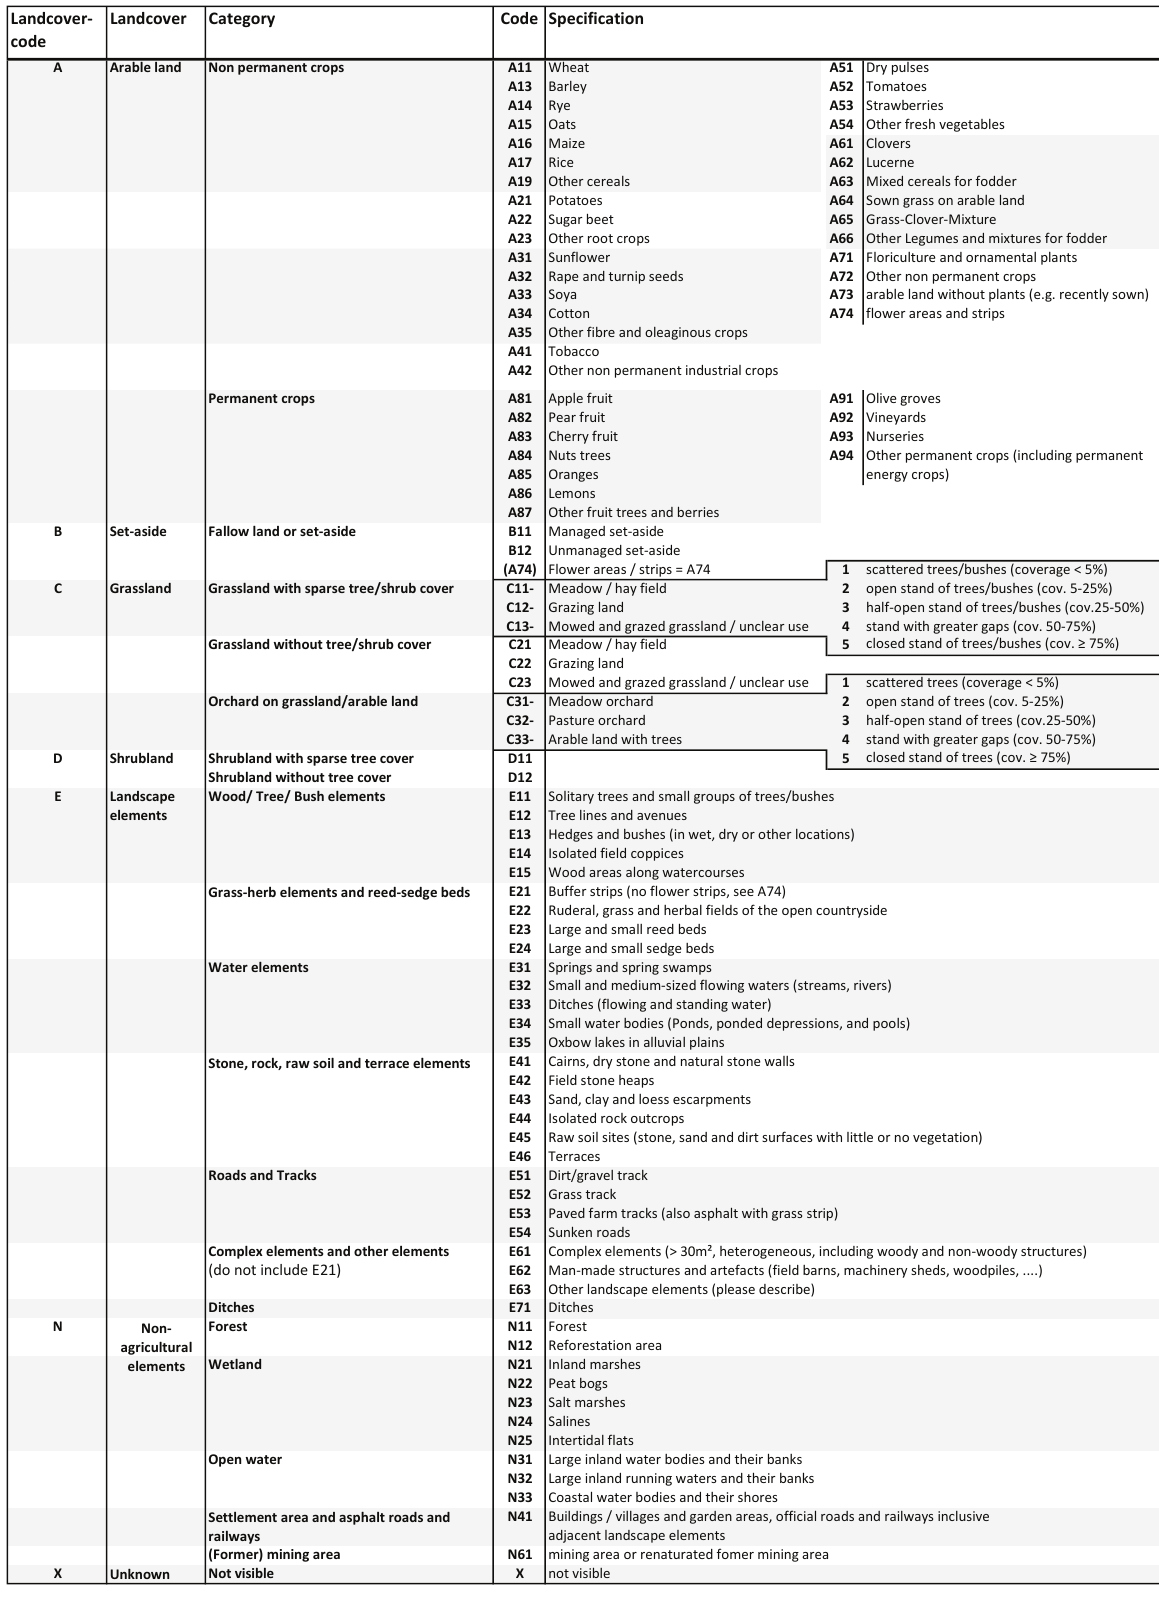
Table S1. Land cover code list